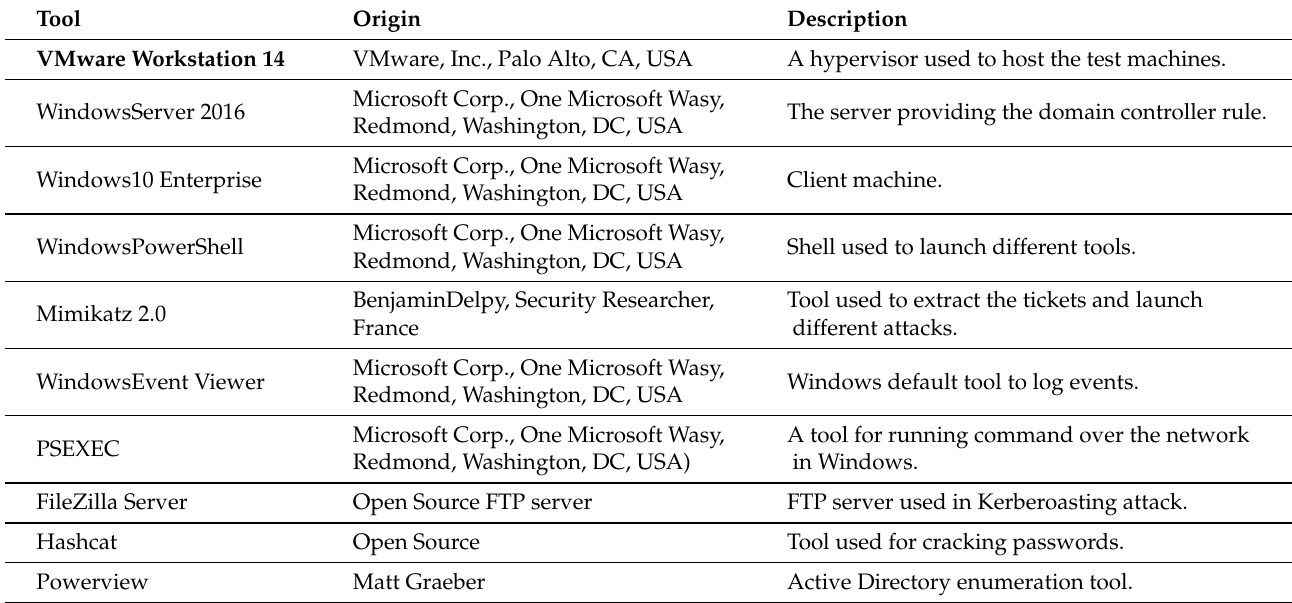
Table 4. Software Tools of the Experimental